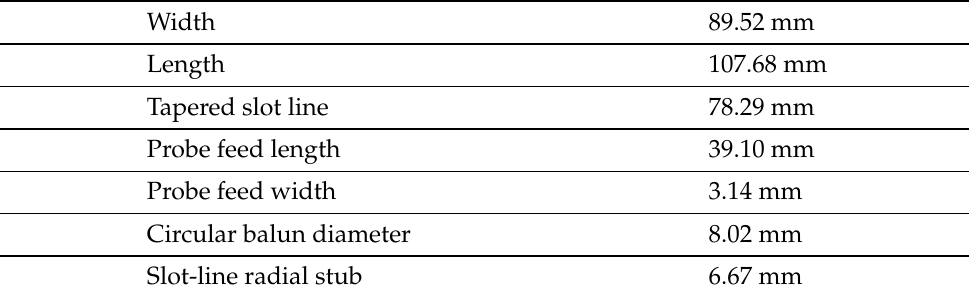
Figure 2. Front and back views of Vivaldi antenna. Table 1. Dimensions of the Vivaldi